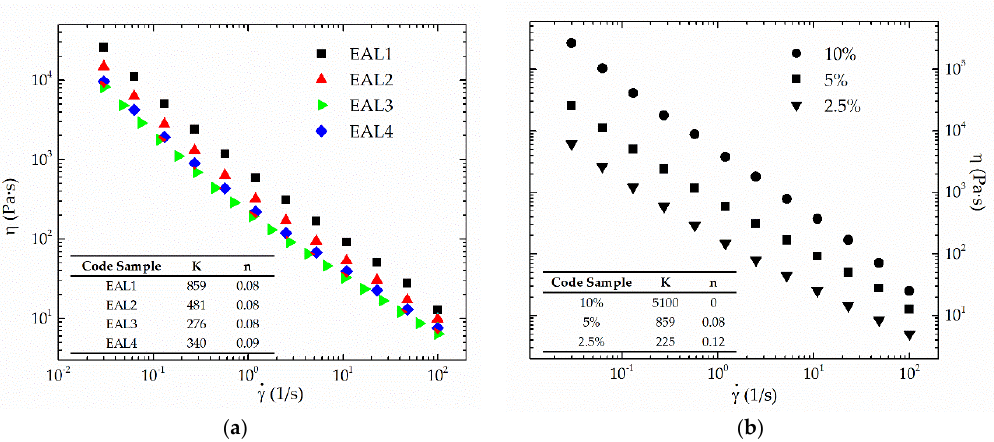
Figure 3. Viscous flow curves at 25 °C for epoxidized lignin-based oleogels as a function of ( a ) lignin